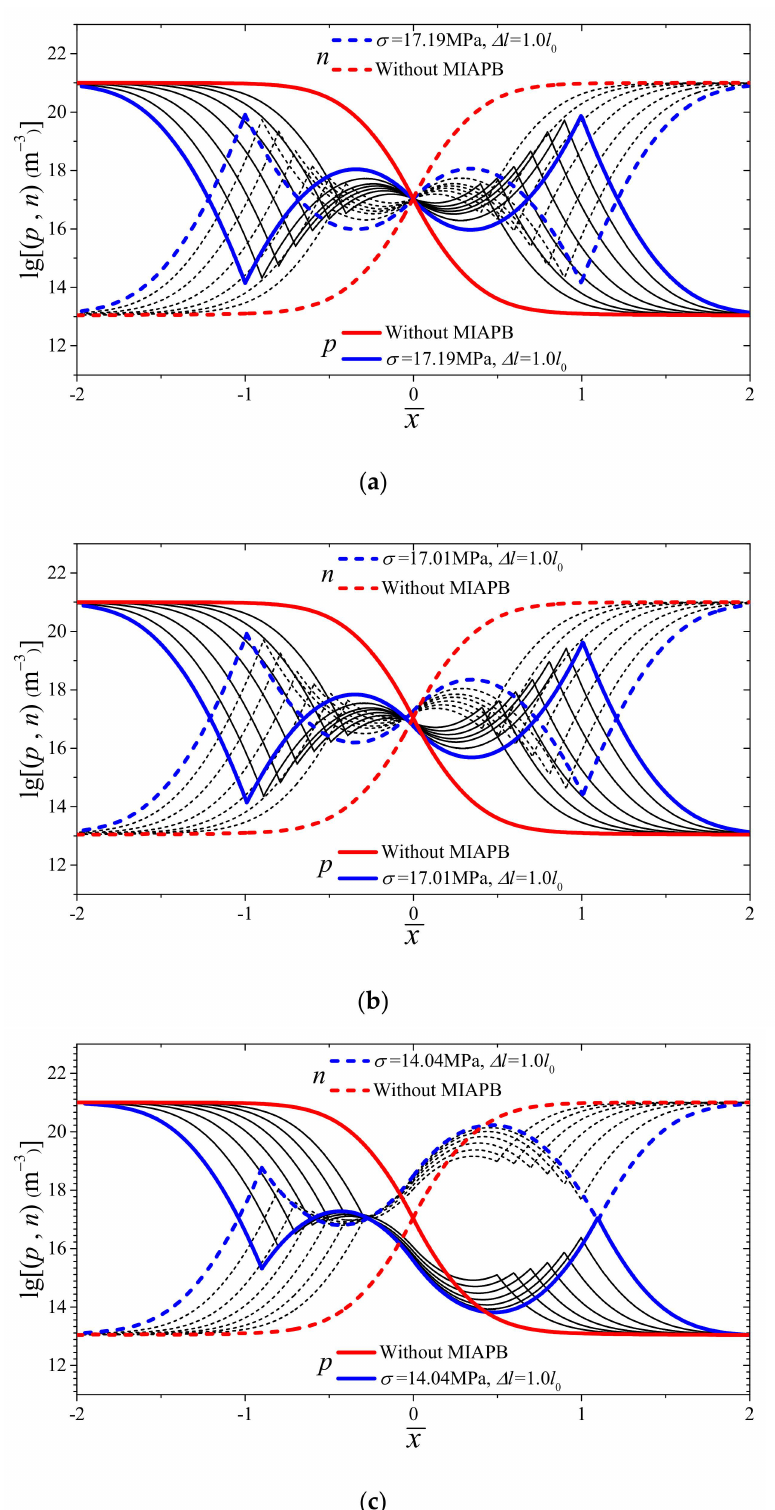
Figure 2. Evolutionary process of carrier concentration corresponding to the maximum output current under different offset conditions when ∆ l varies from 0.4 l 0 to 1.0 l 0 . ( a ) L A / l 0 = 0; ( b ) L A / l 0 = 0.01; ( c ) L A / l 0 =